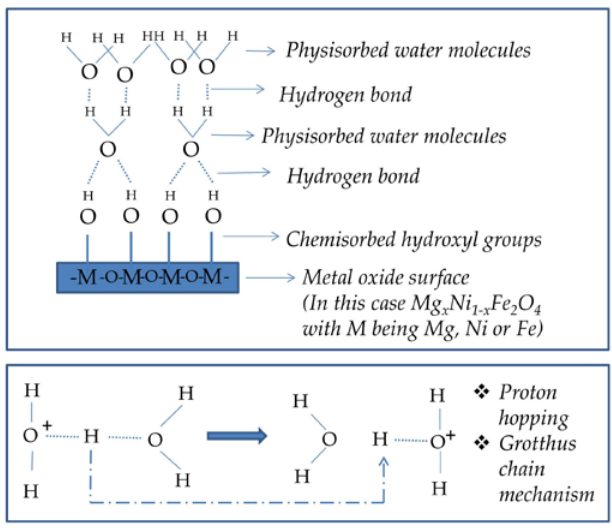
Figure 10. Scheme of the humidity detection mechanism. In the case of nickel–magnesium ferrites, all of the synthesized samples were tested at a constant temperature of 25 °C (room temperature). With an increase in relative hu- midity from 40% to 90%, there is a noticeable decrease in the impedance and complex impedance magnitude in each of the synthesized materials, as shown in Figure 11 for Ni 07 Mg 0.3 Fe 2 O 4 . The impedance of pure MgFe 2 O 4 decreased 277 times with an RH increase from 40% to 90%, which corresponds well to and is higher than in the research of Je- seentharani et al. [70], in whose case the impedance of MgFe 2 O 4 in the form of pellets decreased 230 times from 5% to 98% RH.